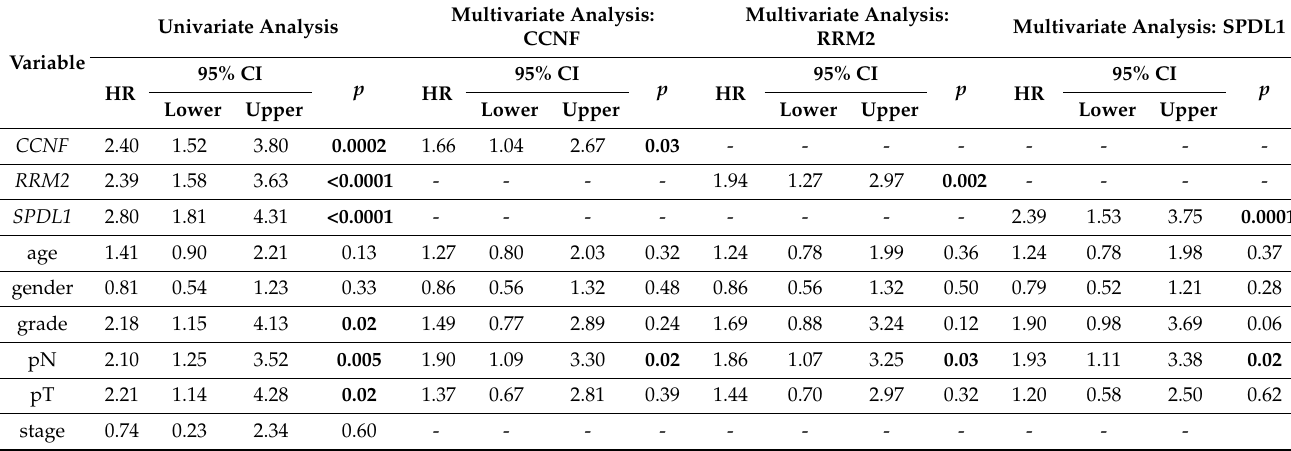
Table 3. Univariate and multivariate Cox proportional hazards models for OS of TCGA patients with PAC ( n = 177). Univariate Variable